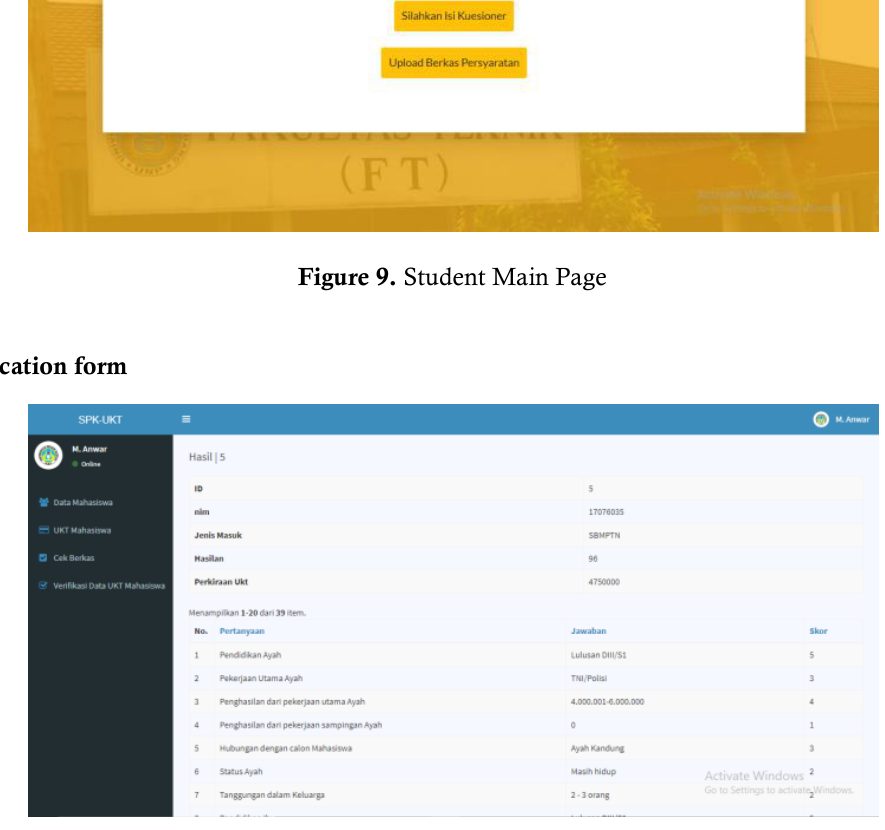
Figure 10. STF Verification Form